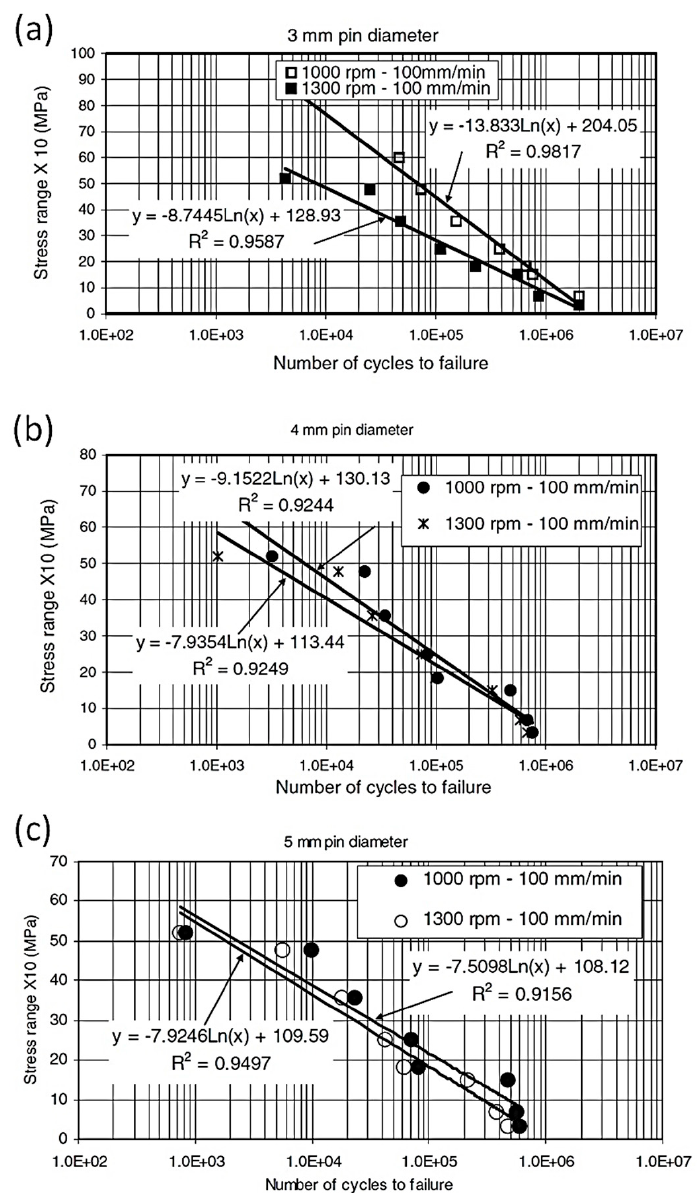
Figure 6. Fatigue performance of FSW lap joints was obtained with ( a ) 3 mm ( b ) 4 mm, and ( c ) 5 mm pin diameter and different tool rotations [43]. Reprinted from: Effects of tool rotation and pin diameter on fatigue properties of friction stir welded lap joints, The International Journal of Advanced Manufacturing Technology 36 (2008): 877–882, Kulekci, Mustafa Kemal, Aydin ¸Sik, and Erdinç Kaluç. Copyright 2006, with permission from Springer